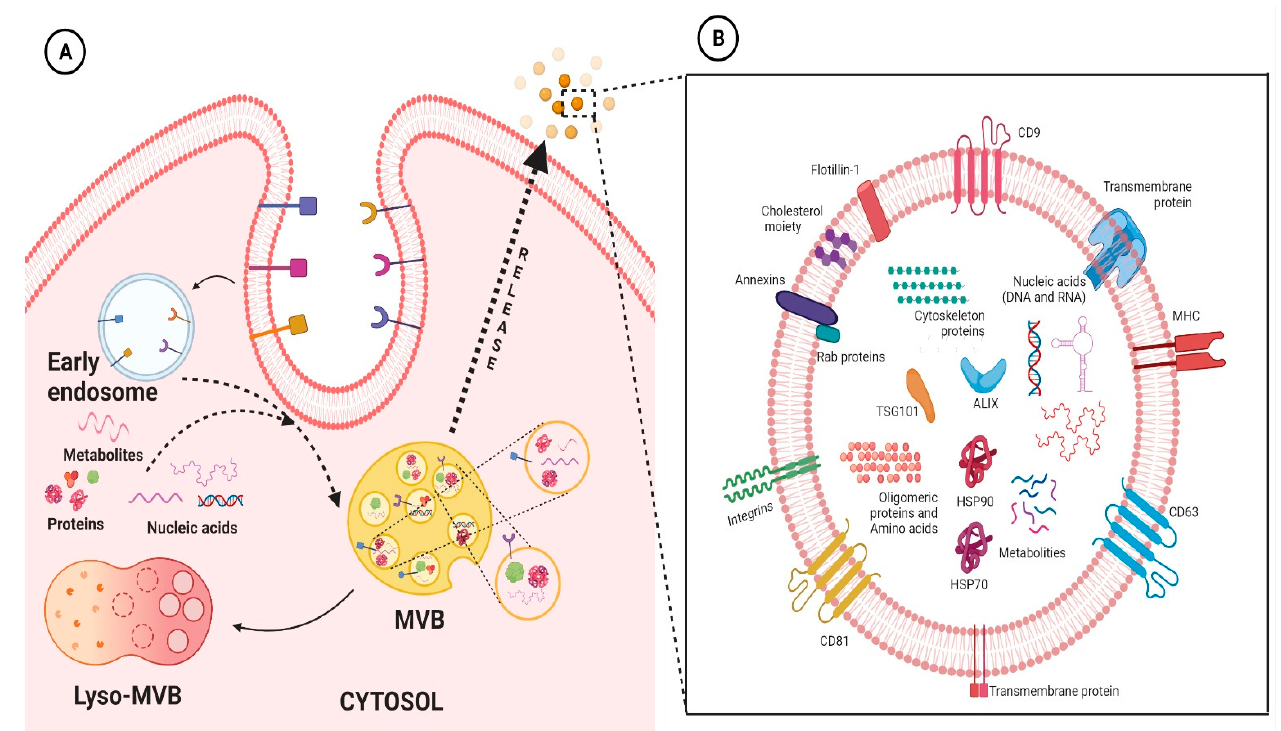
Figure 1. Representative figure highlighting the biogenesis of exosomes ( A ) and the typical structure of exosomes ( B ). Basically, exosome biogenesis starts with the inward vagination of the cellular membrane to form early endosomes. Thereafter, the intraluminal vesicles (ILVs) are formed, and the endosomes mature to multivesicular bodies (MVBs). MVBs fuse with the cellular membrane to release ILVs into the extracellular space, where thereafter they are denoted as exosomes. On the other hand, these MVBs can fuse with lysosomes of the cell, resulting in the degradation of ILVs ( A ). Exosomes contain various molecular entities, including nucleic acids (DNA and/or RNA), membrane anchored-proteins, cytosolic proteins, and lipids ( B ). The figures are prepared with the BioRender Software (biorender.com).